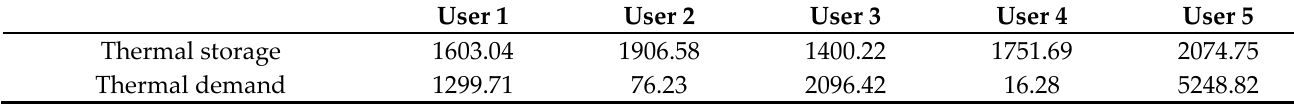
Table 4. Thermal storage and thermal demand of the home hotels